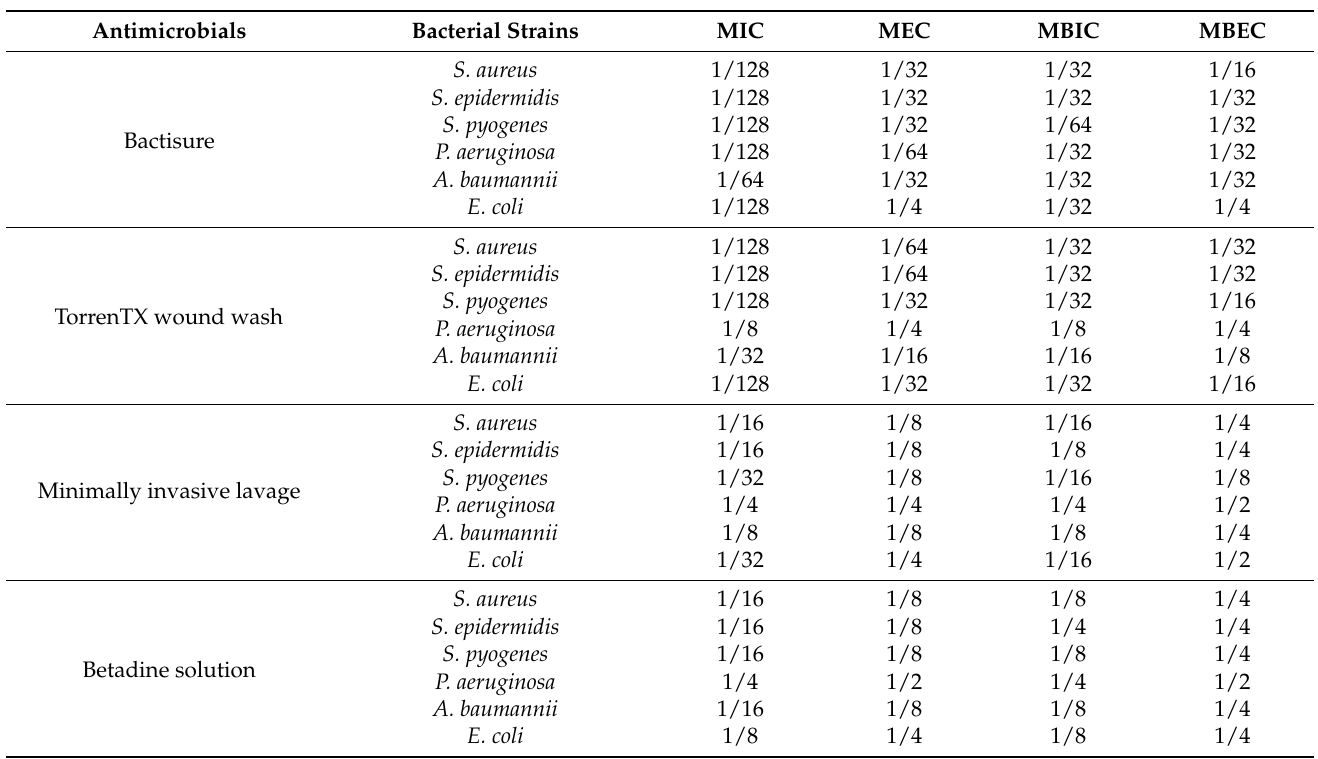
Table 2. Maximum possible dilution of surgical washes to give MIC, MEC, MBIC, and MBEC based on 24 h contact time.